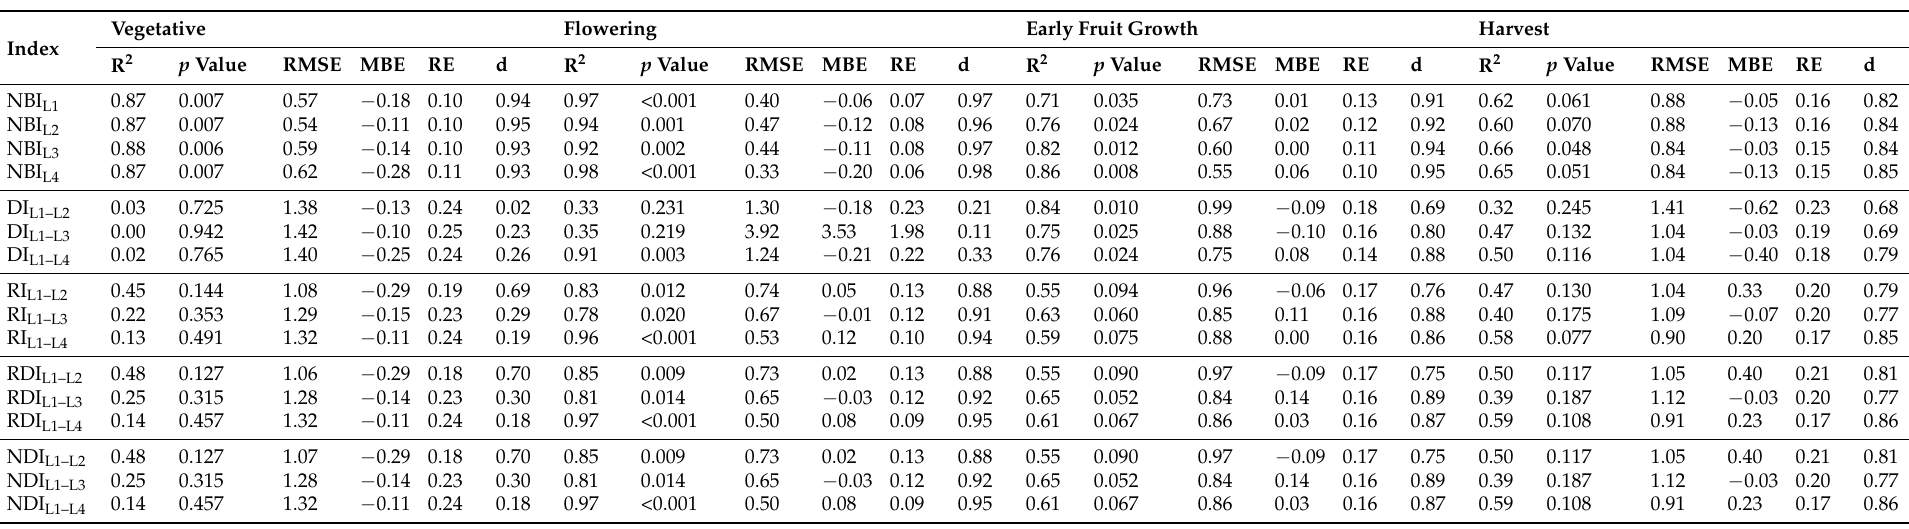
Table 7. Results of the validation analysis of the estimated fruit yield (kg m − 2 ) from NBI measurements and several normalized NBI indices (DI, RI, RDI, NDI), at different phenological stages of sweet pepper. DI, Difference Index; RI, Relative Index; RDI, Relative Difference Index; NDI, Normalized Difference Index, R 2 , coefficient of determination; RMSE, root mean square error; RE, relative error; MBE, mean bias error; d, Willmott Index. L 1 , L 2 , L 3 and L 4 , refer to the latest (most recent), second, third and fourth fully expanded leaf,